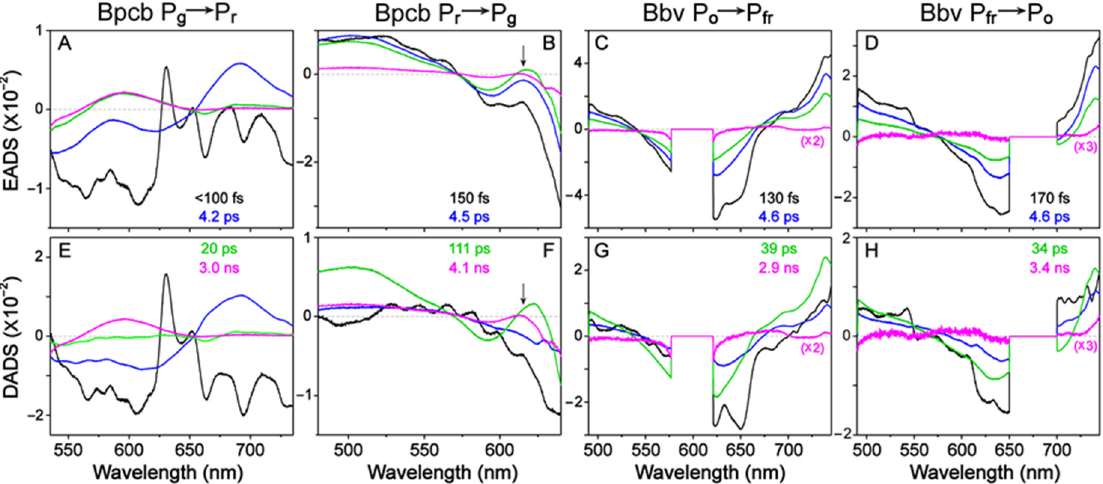
Figure 3. Global analysis of the fs-TA spectra during CBCR photoswitching processes. The underlying EADS/DADS of Bpcb P g → P r , Bpcb P r → P g , Bbv P o → P fr , and Bbv P fr → P o transitions are shown in panels ( A , E ), ( B , F ), ( C , G ), and ( D , H ), respectively. The retrieved spectra are ordered from fastest to slowest lifetimes in black, blue, green to magenta traces, with the associated lifetimes color-coded and listed in insets. To remove pump scattering effect on data analysis, the probe window was truncated when the scattering signal was on the edge of detection window (panels ( A , B , E , F )) or scattering region was set to zero (panels ( C , D , G , H )). Black arrows in panels ( B , F ) show a weak ESA band at ~615 nm.